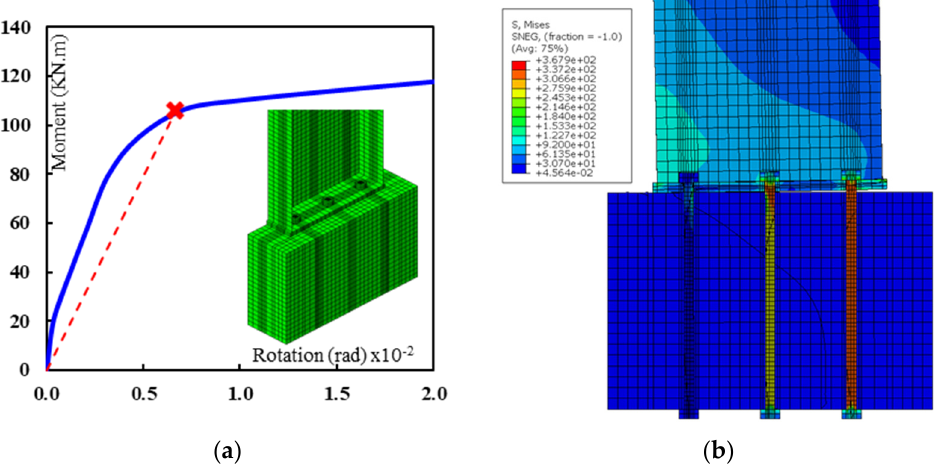
Figure 12. Specimen B6-D18-S150-T18: ( a ) moment–rotation curve, ( b ) deformed shape–von misses stress at H/150 column drift.